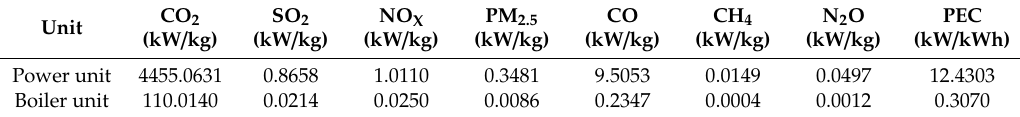
Table 8. Basic data for plant manufacturing.